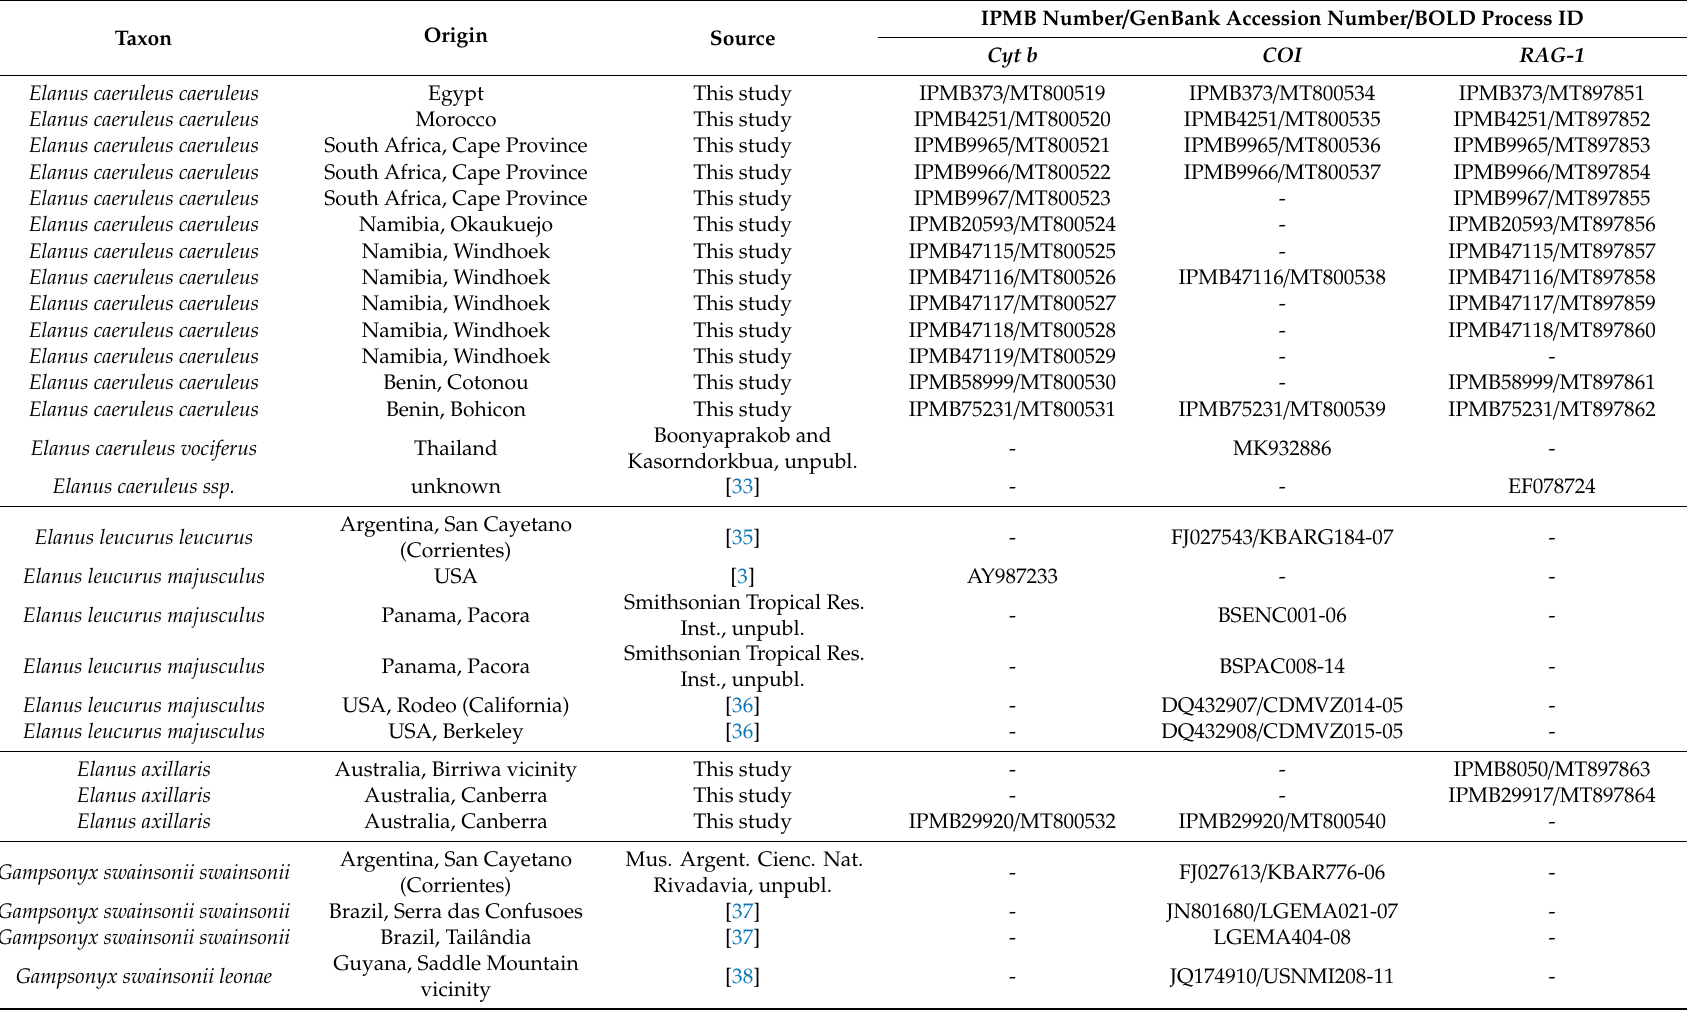
Table 1. Samples of Elanin kites used in the phylogenetic